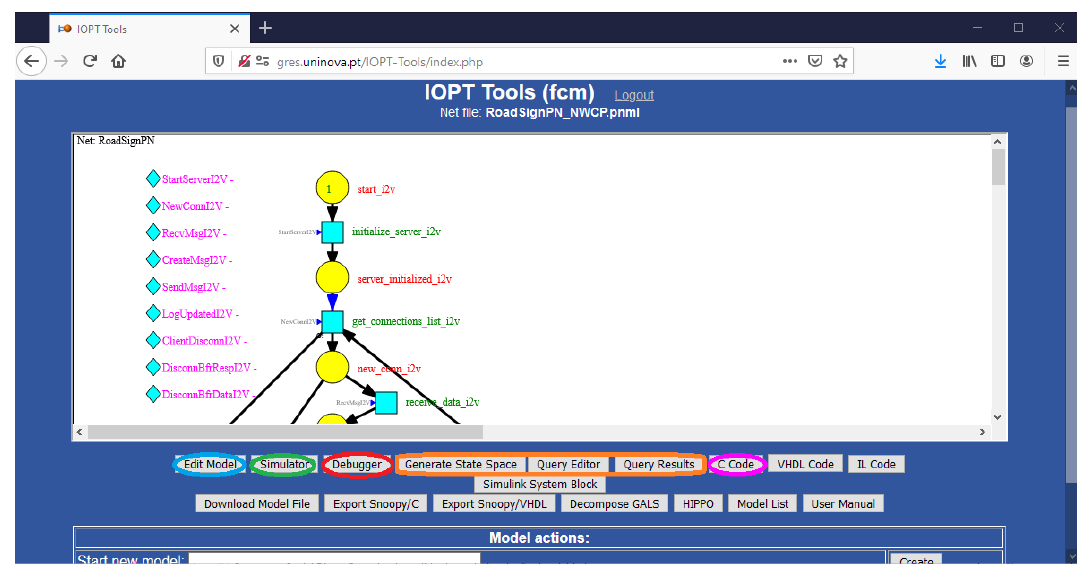
Figure 10. IOPT-Tools main interface.